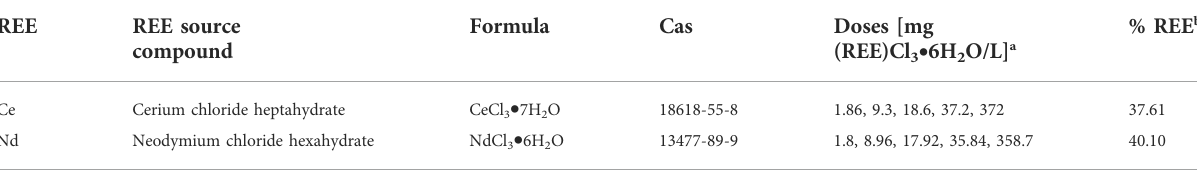
TABLE 1 Sources of rare earth elements (REEs) and range of